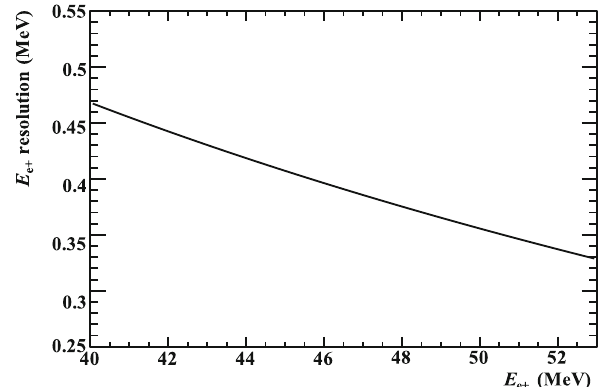
Fig. 8 E e + resolution as a function of E e